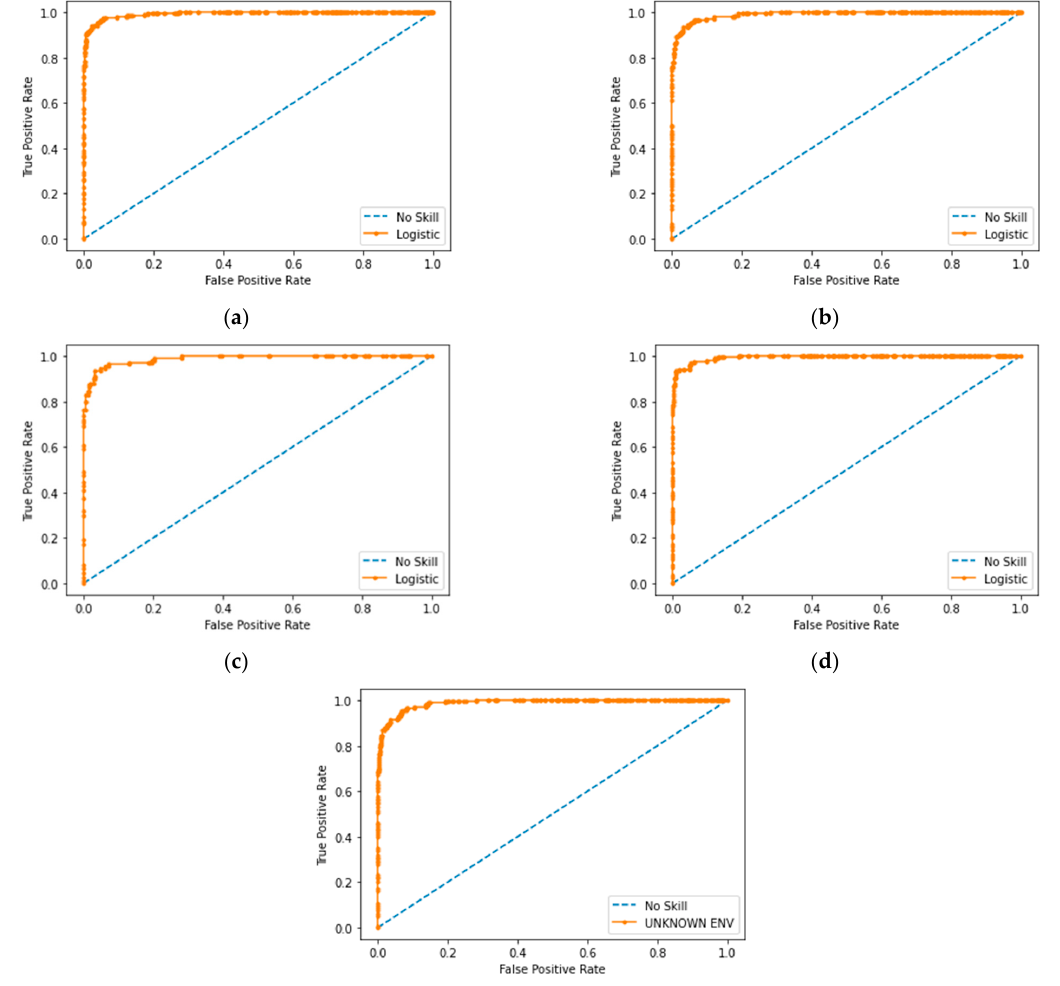
Figure 18. ROC curve of prediction in ( a ) Environment 1; ( b ) Environment 2; ( c ) Environment 3; ( d ) Environment 4 and ( e ) Environment 5.